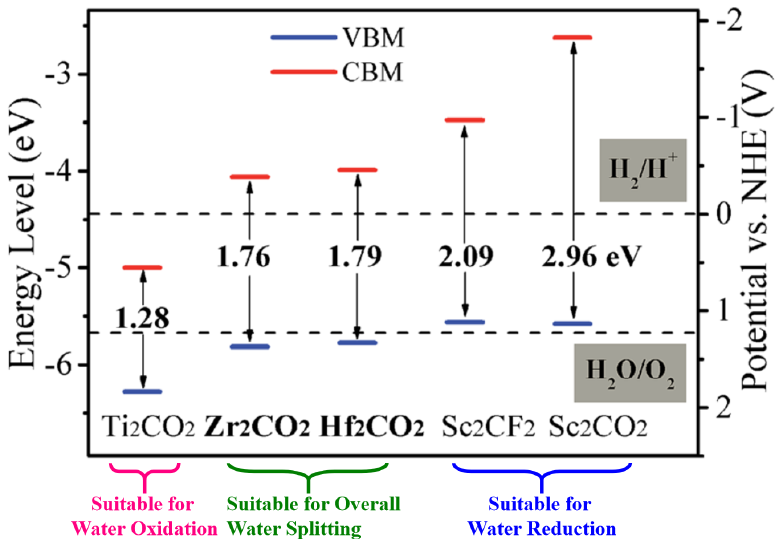
Figure 15. Band alignments of some typical 2D MXenes with respect to the water reduction and oxidation potential for photocatalytic water splitting. Reproduced with permission from reference [176]. Copyright 2016, Royal Society of